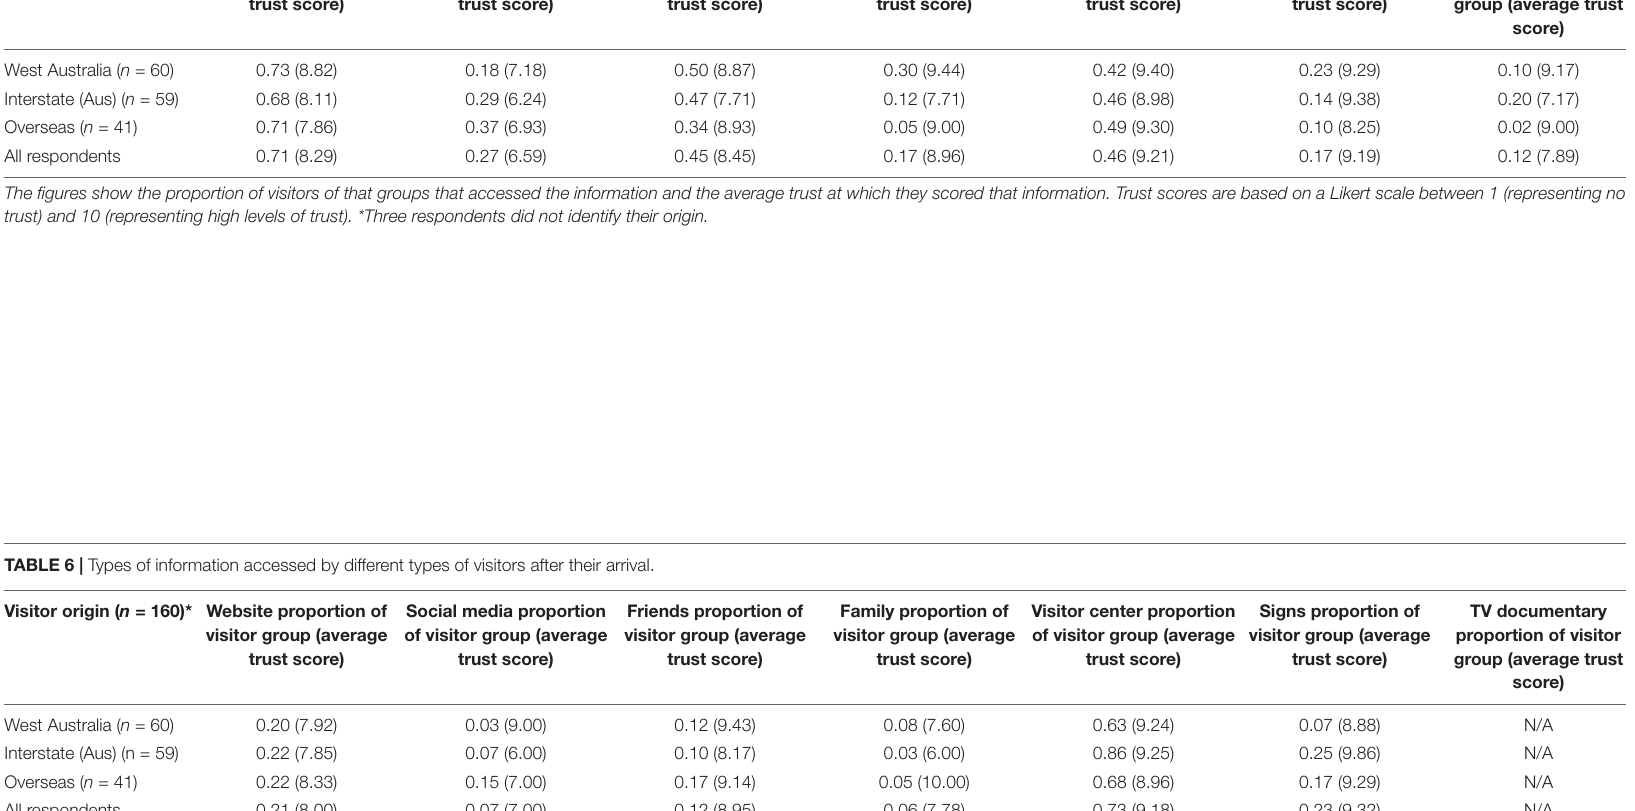
TABLE 5 | Types of information accessed by the different types of visitors prior to their arrival. Visitor origin ( n = 160)* Website proportion of visitor group